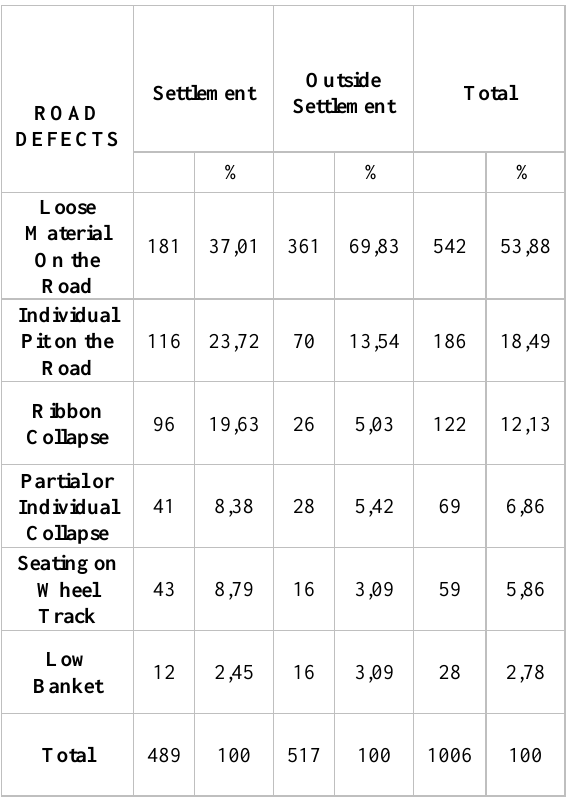
Table 1. Information Regarding Cause Highways For Death And Injured Traffic Accidents –